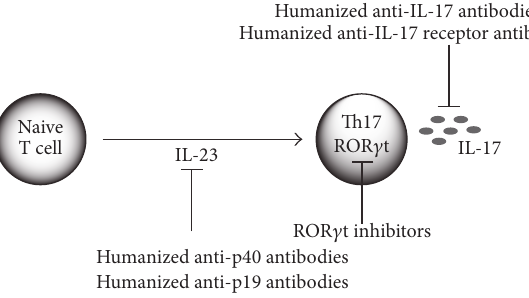
Figure 2: Tools for targeting the Il-23-Th17 axis. Various therapeutic tools are available to target the interlukin-23-Th17 pathway.